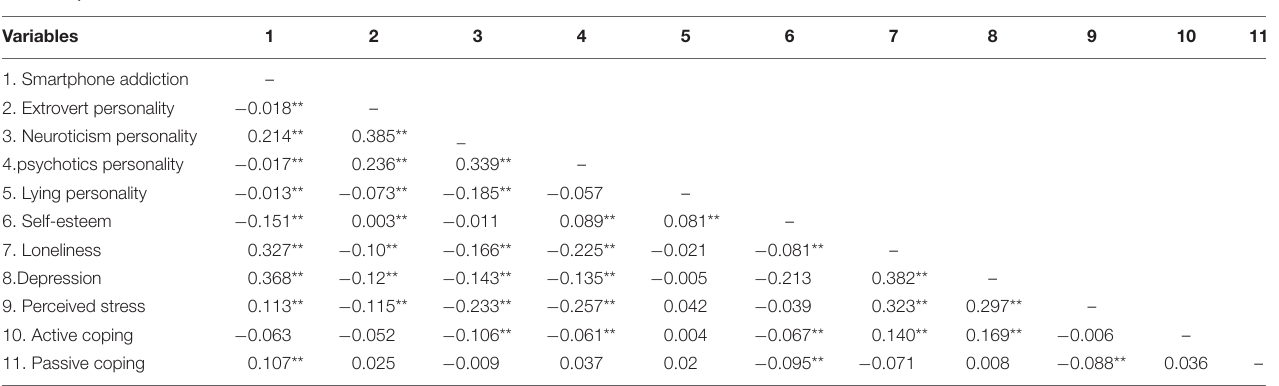
TABLE 2 | Pearson correlation matrix for observed